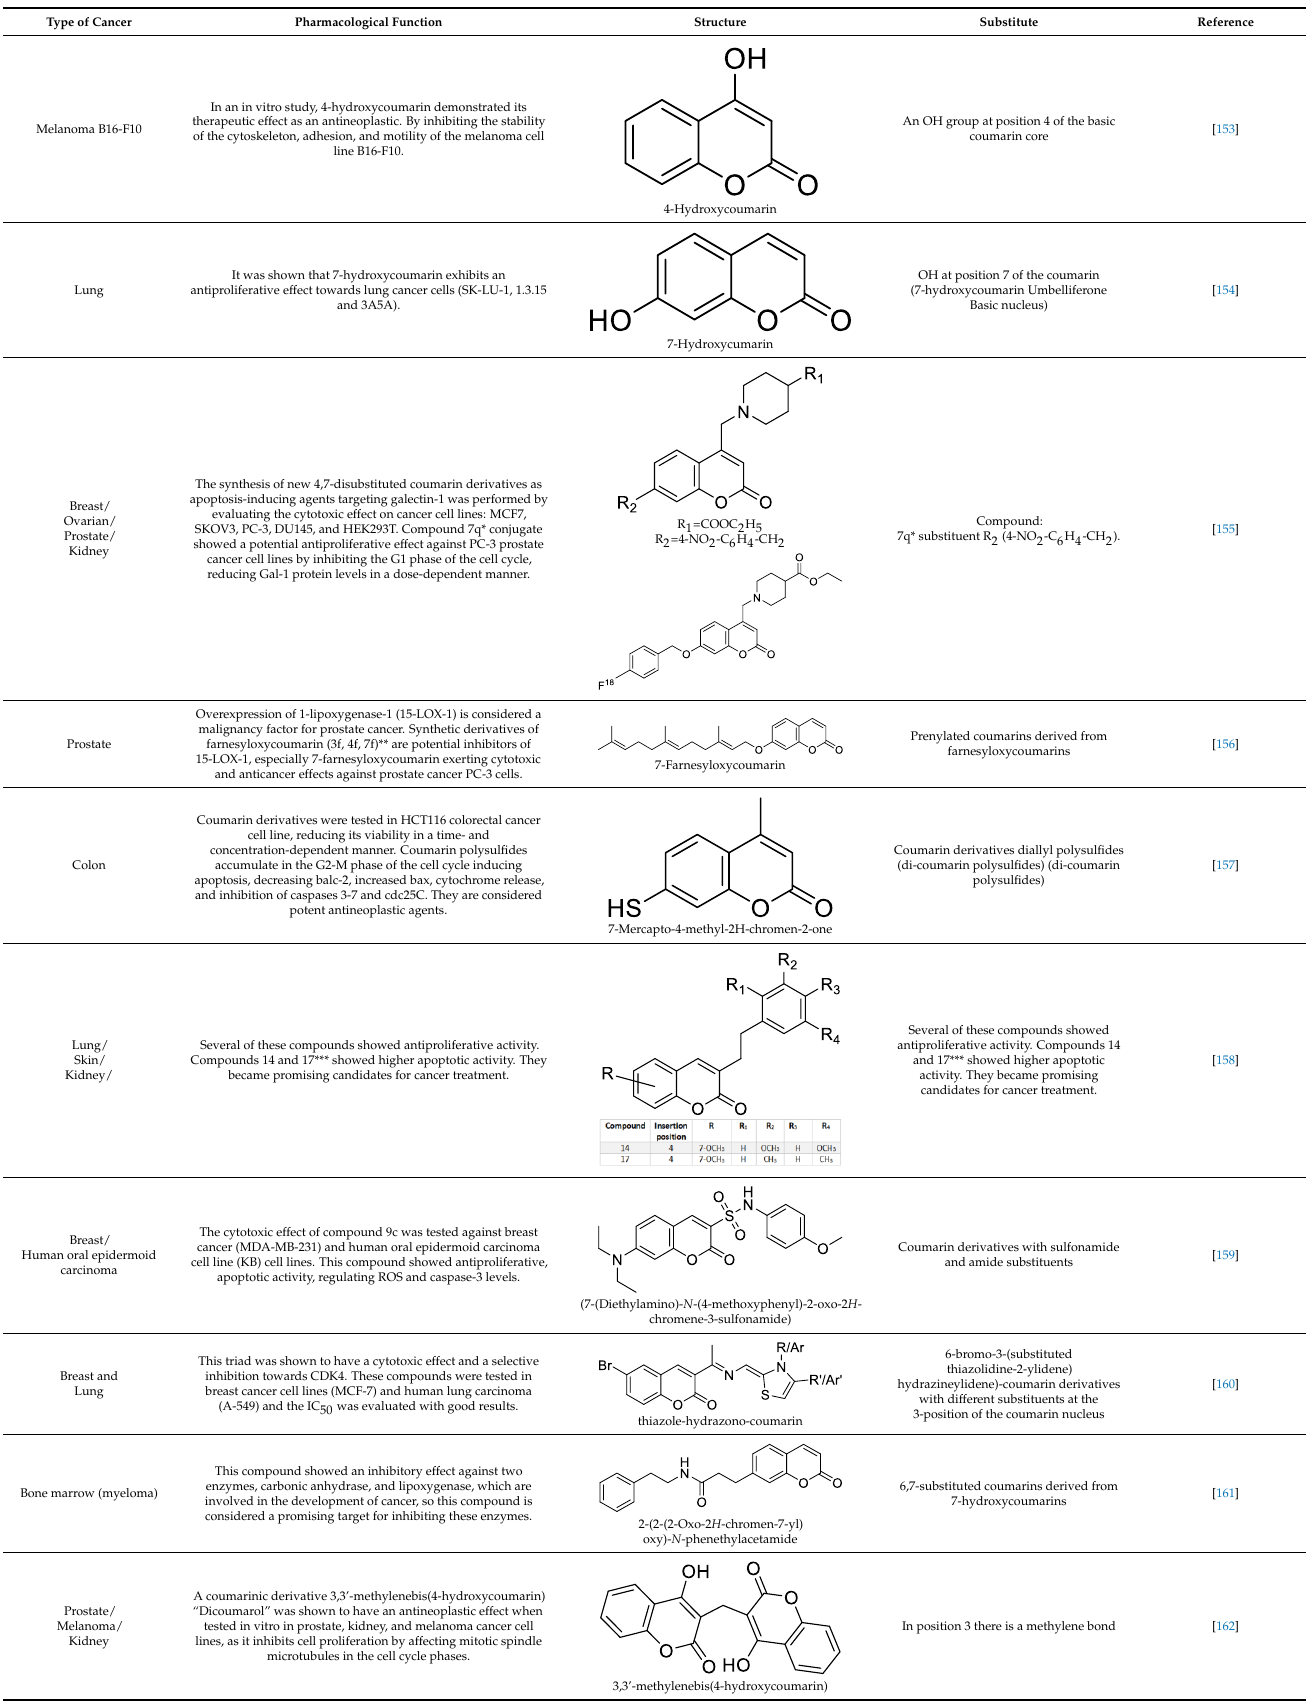
Thesynthesisofnew4,7-disubstitutedcoumarinderivativesas apoptosis-inducingagentstargetinggalectin-1wasperformedby evaluatingthecytotoxiceffectoncancercelllines: MCF7, SKOV3,PC-3,DU145,andHEK293T.Compound7q*conjugate showedapotentialantiproliferativeeffectagainstPC-3prostate cancercelllinesbyinhibitingtheG1phaseofthecellcycle, reducingGal-1proteinlevelsinadose-dependentmanner.